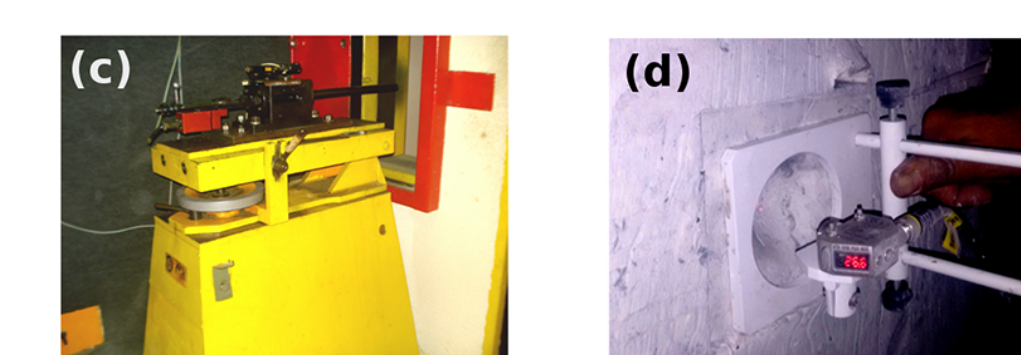
(3) is the velocity of i its r